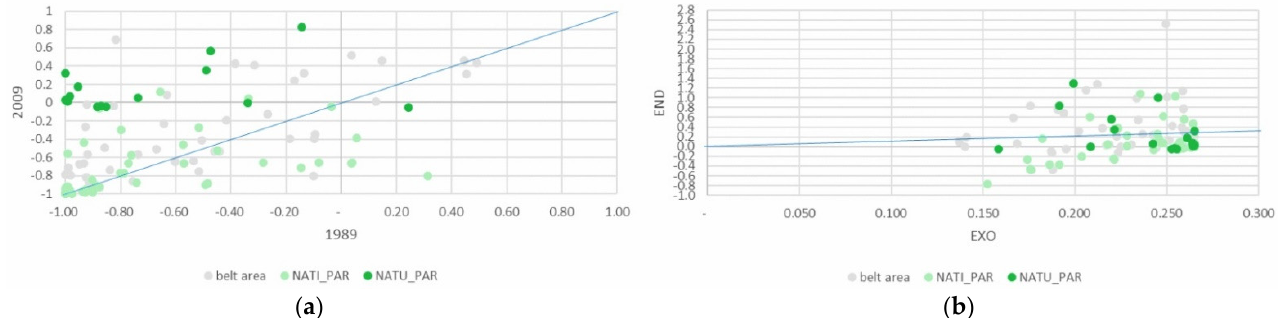
Figure 4. ( a , b ) Sierra Nevada- PSI and DPSI for olive tree cultivation. Source: Drawn up by the authors using data from the 1989 and 2009 Agrarian Censuses, Ministry of Agriculture. Trends in the Specialization in Orchards